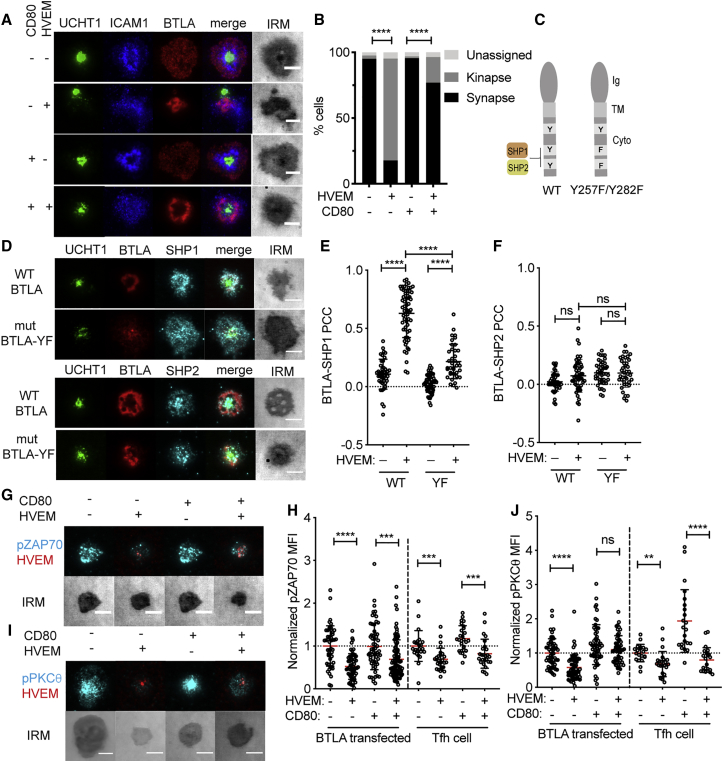
BTLA-HVEM at the Immunological Synapse Recruits SHP1 to Inhibit Signaling in Tfh Cells(A) Example total internal reflection fluorescence (TIRF) and interference reflection microscopy (IRM) images of BTLA-transfected human CD4+ T cell blasts on supported lipid bilayers containing anti-CD3, ICAM1, and where indicated, HVEM and/or CD80. Staining for CD3 (UCHT1), ICAM1, and BTLA is shown.(B) Quantification of kinapse versus synapse state of cells imaged as in (A).(C) Model of human BTLA binding mutant Y257F/Y282F, designed to disrupt SHP1 and SHP2 recruitment to the last two of four cytosolic tyrosines.(D) Representative images of SHP1 and SHP2 recruitment to the synapse in relation to that of WT or mutant BTLA.(E and F) Quantification of SHP1 (E) and SHP2 (F) colocalization with WT or mutant BTLA with or without HVEM in the bilayer as determined with Pearson’s colocalization coefficient.(G) Representative images of pZAP70 in human Tfh cells in relation to HVEM in the bilayer after 15 min on the bilayer; a standardized lookup table (LUT) is shown across panels so fluorescence can be directly compared.(H) Relative amount of pZAP70 in BTLA-transfected CD4+ T cell blasts and Tfh cells with or without HVEM and CD80 in the bilayer (normalized to the condition without HVEM and CD80).(I) Representative images of pPKCθ in human Tfh cells in relation to HVEM in the bilayer after 15 min on the bilayer; a standardized LUT is shown across panels so fluorescence can be directly compared.(J) Relative amount of pPKCθ in BTLA-transfected CD4+ T cell blasts and Tfh cells with or without HVEM and CD80 in the bilayer (normalized to the condition without HVEM and CD80). Data are pooled from three independent donors and experiments.Scale bars: 5 μm. Chi-square and Fischer’s exact tests (B) or Mann-Whitney test (E, F, H, and J): ∗p < 0.05, ∗∗p < 0.01, ∗∗∗p < 0.001, ∗∗∗∗p < 0.0001. See also Figure S4.